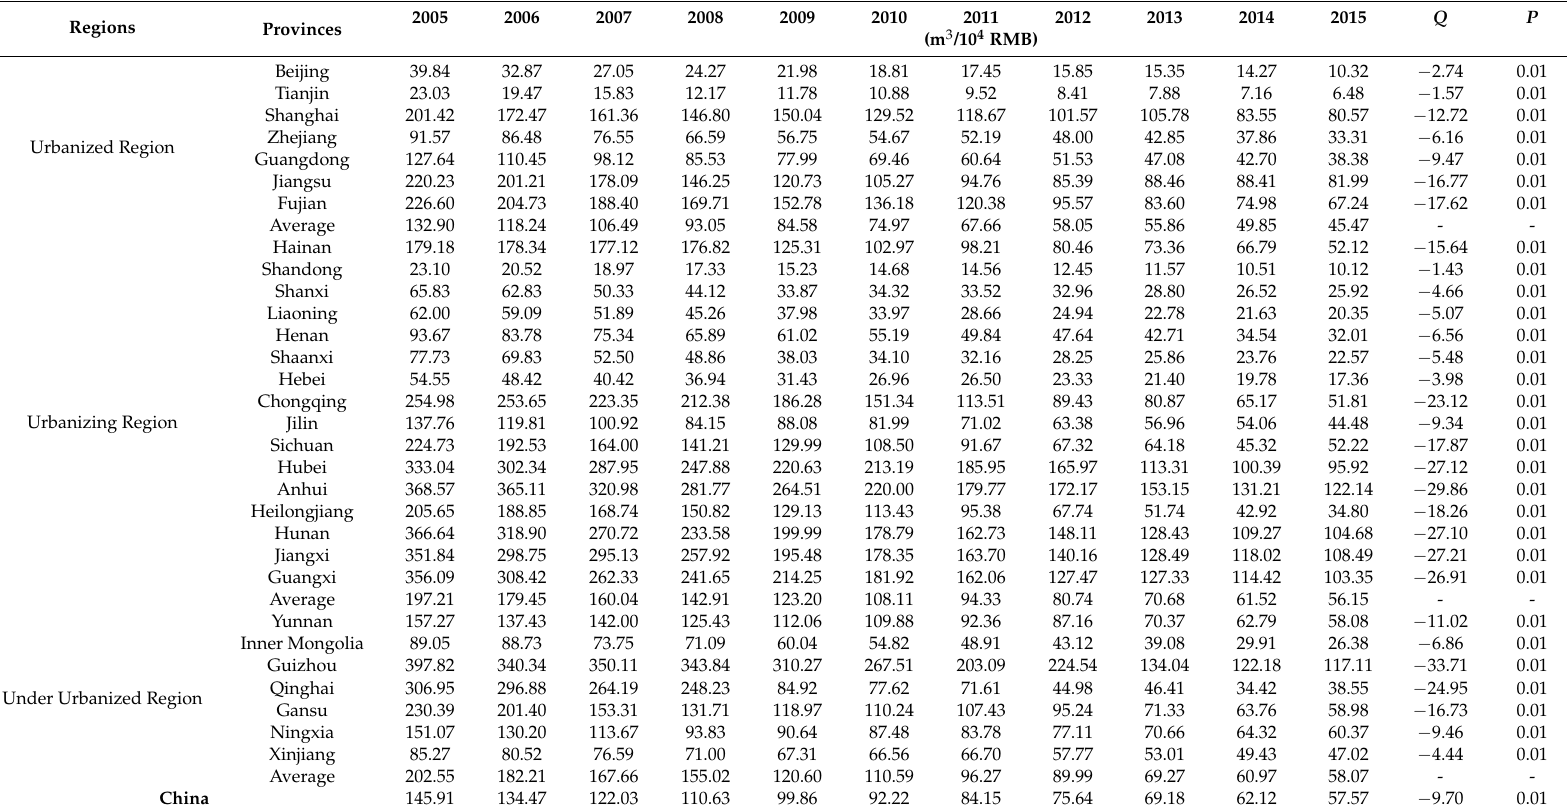
Table A3. China’s water use intensity (WUI), Sen’s slope (Q), and significance level (P) of secondary industry (SI) at provincial and national levels between 2005 and 2015.